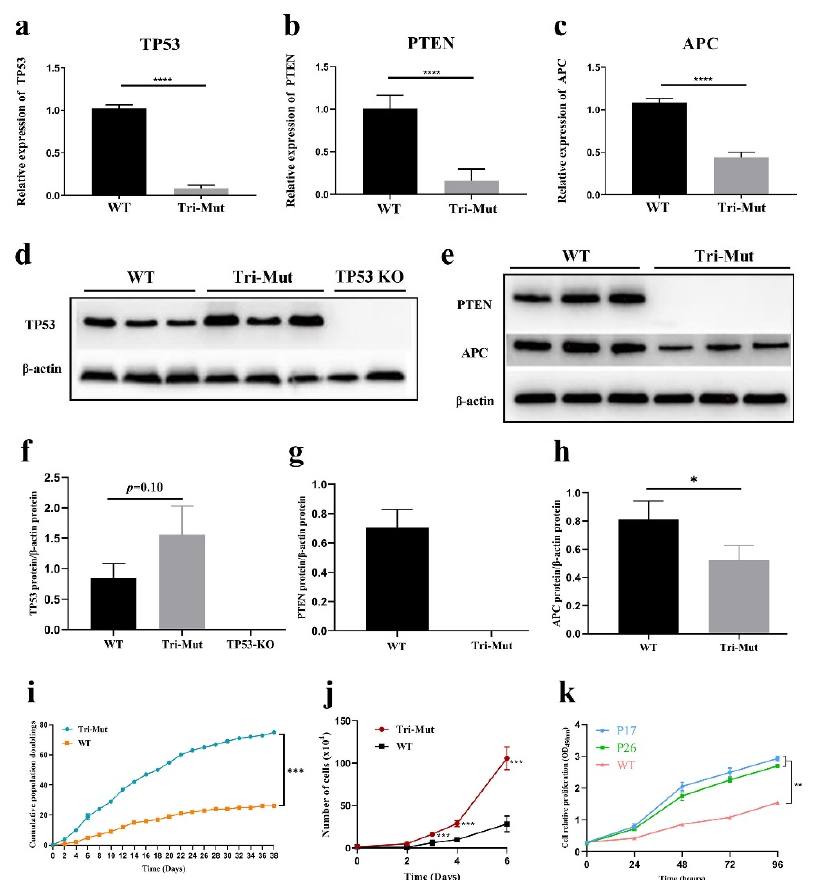
Figure 4. RT-PCR detection and Western blot analysis of the three targeted genes and proliferation ability analyses of Tri-Mut cells. The relative expressions of TP53 ( a ), PTEN ( b ), and APC ( c ) detected with the qPCR assay. Western blot analyses of TP53 ( d ), PTEN, and APC ( e ). The TP53 KO cells were from our previous study [31]. Quantitative analyses of protein levels of TP53 ( f ), PTEN ( g ), and APC ( h ). ( i ) Comparison of the population doublings of Tri-Mut and WT cells. ( j ) Comparison of relative proliferation rates of P4 Tri-Mut cells and WT cells ( × 10,000 cells) per well in 6-well plates. ( k ) Proliferation profiles of P17 and P26 Tri-Mut cells and P17 WT cells detected with CCK8 kit. Statistical analyses highlight the significant difference between Tri-Mut and WT cells. Data were analyzed by Student’s t -test (* p < 0.05; ** p < 0.01; *** p < 0.001; **** p < 0.0001; ns, not significant) and shown as means ± SEM ( n = 3 independent experiments).